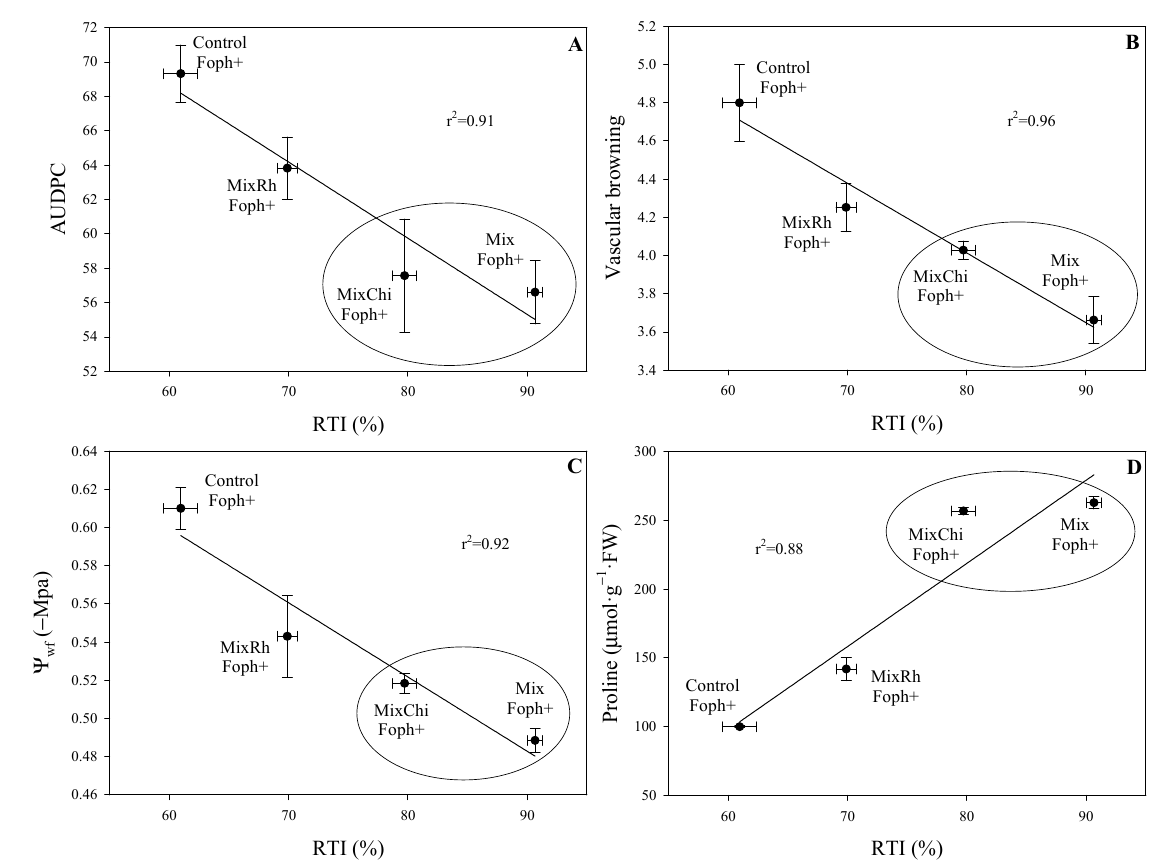
Figure 6. Correlation between ( A ) the area under the disease progress curve (AUDPC), ( B ) vascular browning, ( C ) leaf water potential ( Ψ wf ), or ( D ) proline content and the relative tolerance index (RTI) in cape gooseberry seedlings infected with F. oxysporum f. sp. physali (Foph) and treated with the application of mixtures of biological control agents and organic additives (Mix ( T. virens + B. velezensis ), MixRh ( T. virens + B. velezensis + burnt rice husk), and MixChi ( T. virens + B. velezensis + chitosan) at 50 days after inoculation (DAI). Each point shows the average of five plants. Vertical and horizontal bars represent ± standard error per treatment ( n = 5). Circles represent the group of treatments with greater tolerance to Foph inoculation.